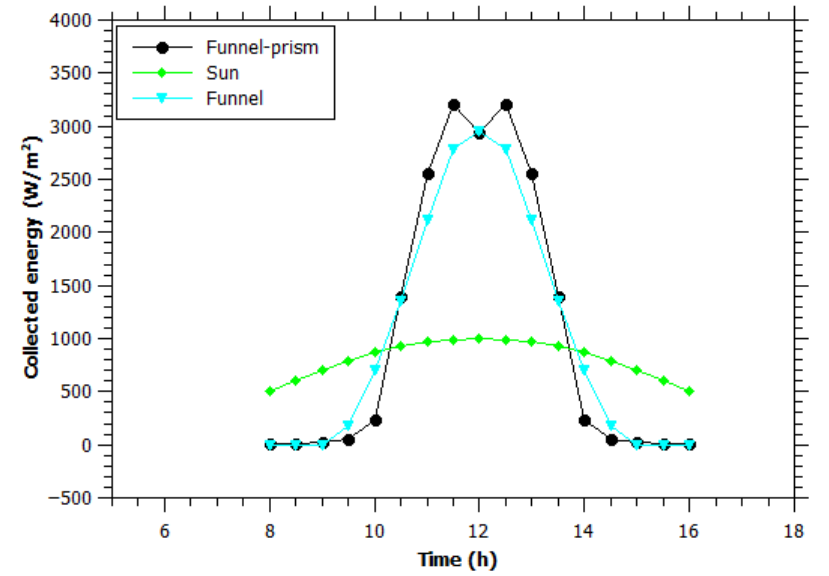
Figure 7. Experimental data of the collected